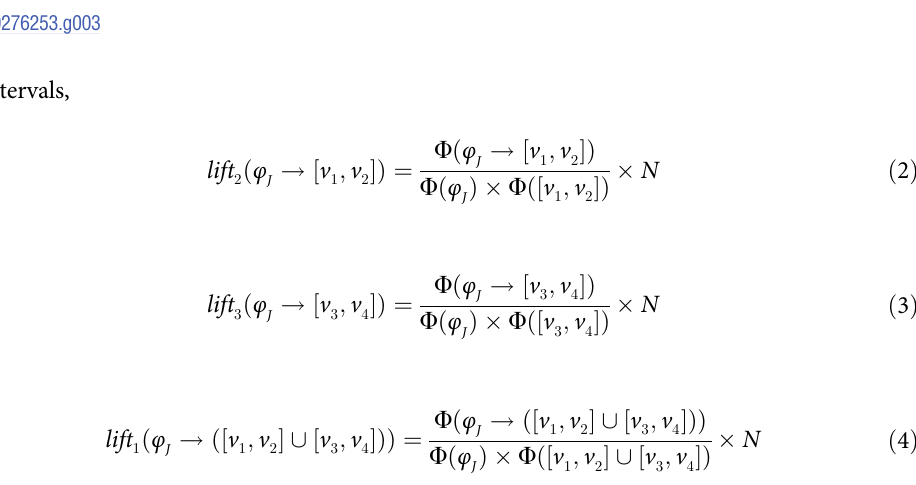
Fig 3. Two empirical distributions represented with relative frequency bins. The blue line represents the outcome variable, and the yellow line the pattern-conditional outcome variable. In this example, four points of intersection between the distributions form two intervals with ranges [ v 1 , v 2 ] and [ v 3 , v 4